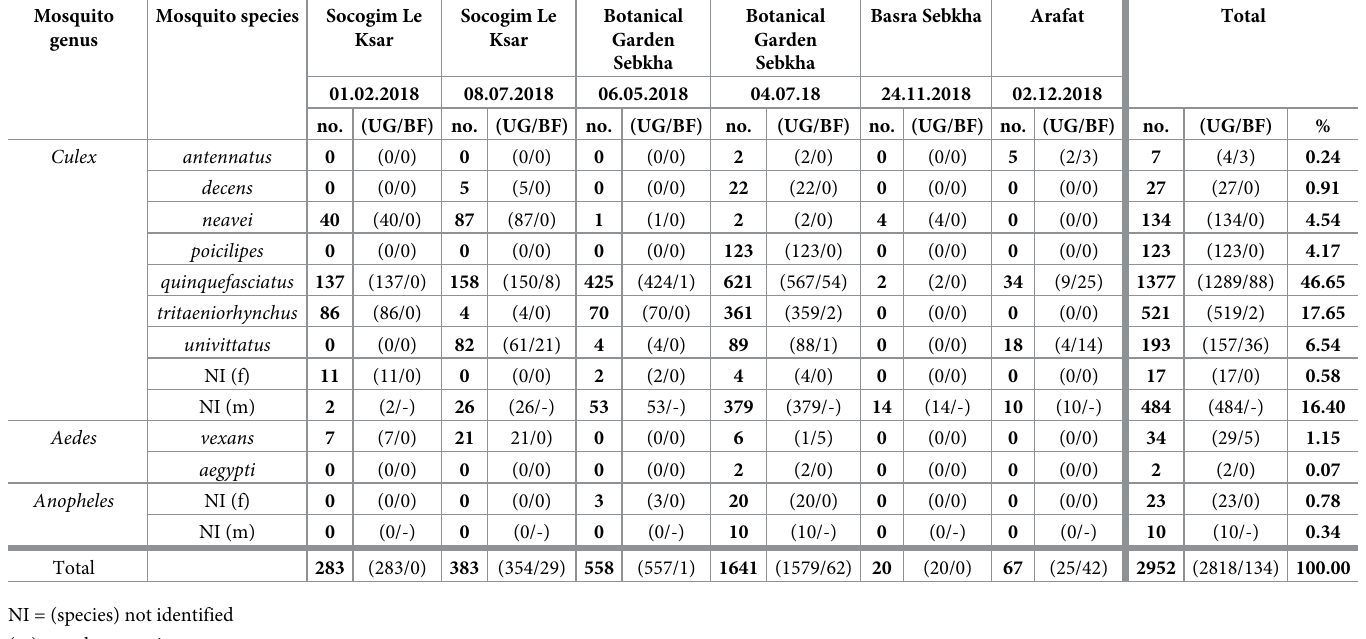
Table 2. Number of collected mosquitoes in Nouakchott and its surroundings. Mosquito Mosquito genus